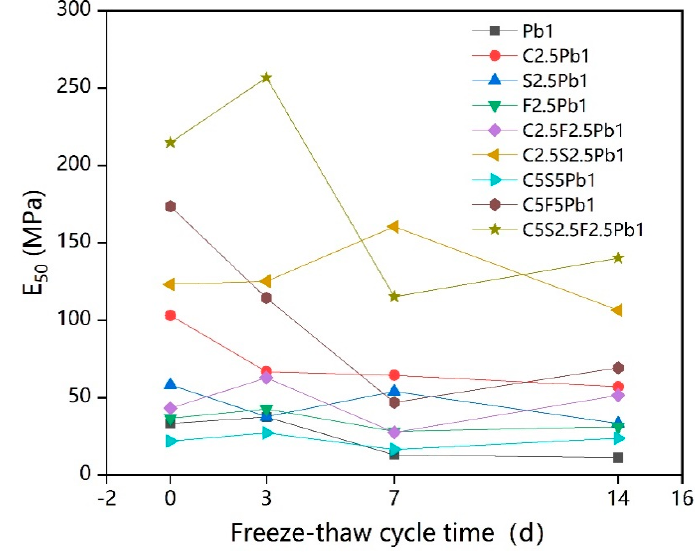
Figure Figure 6. The secant modulus (E (cid:2873)(cid:2868)) of solidified lead-contaminated soils treated under freeze–thaw cycles.